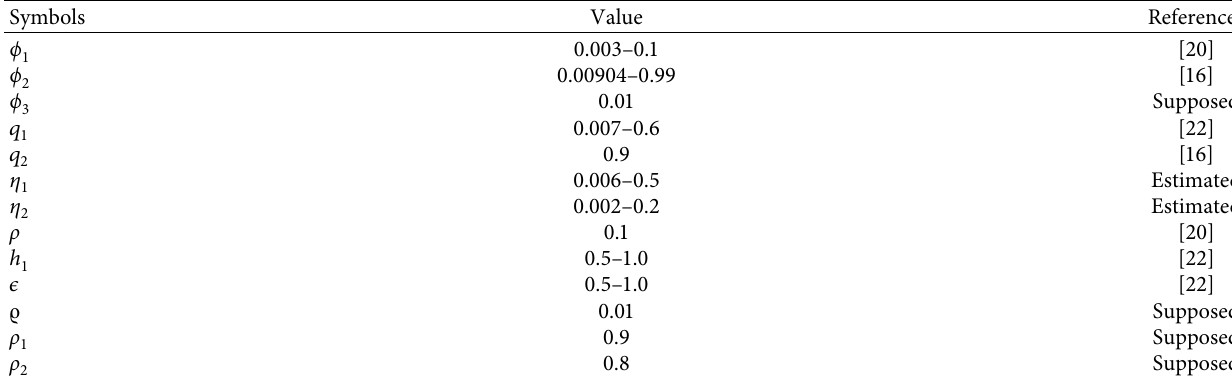
Table 1: Explanation of attributed values assumed in the